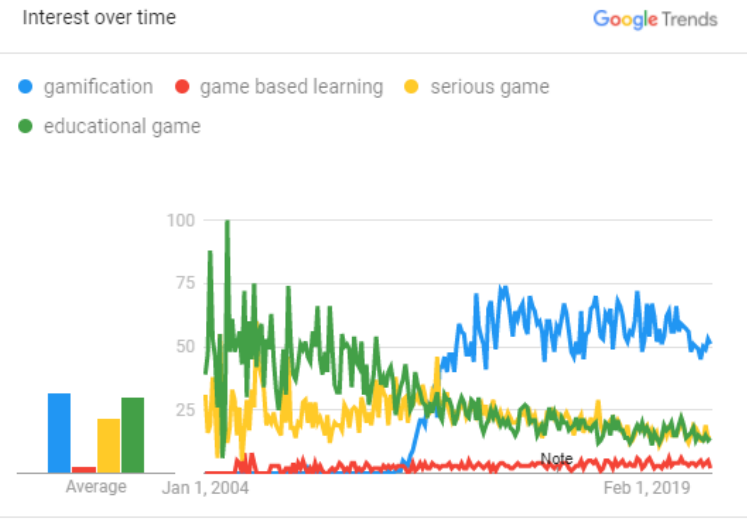
Figure 1. Trends of gamification, game-based learning, educational games, and serious games by using the Google Trends